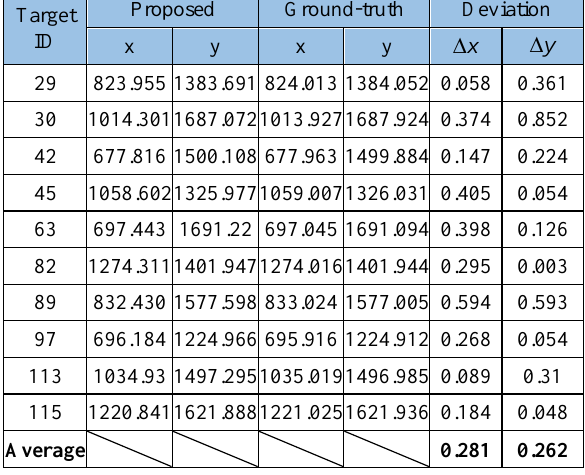
Table 8. Deviation analysis of feature points localization under Gaussian noise environment